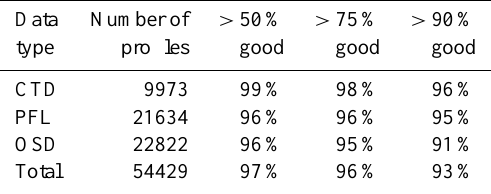
Table 1. Profile statistics per instrument type for 25m vertically binned profiles. Percent good is calculated for both temperature and